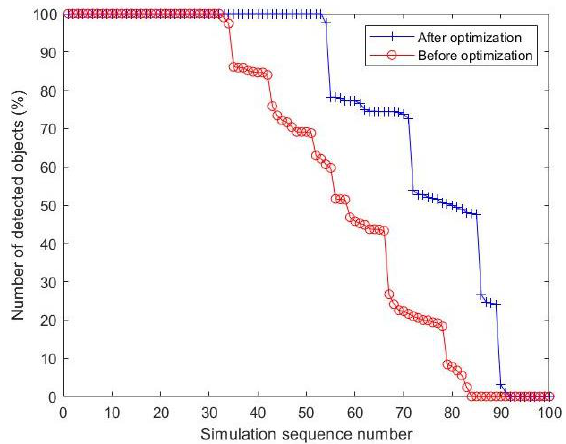
Figure 15. Performance comparison before and after optimization.